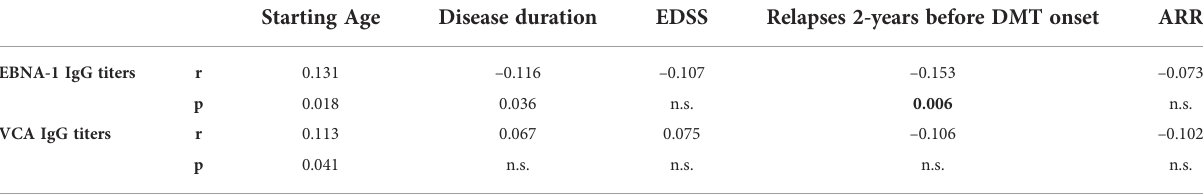
TABLE 3 Correlations between EBNA-1 and VCA IgG titers with different clinical variables in the samples collected before DMT onset in the MS group. Starting Age